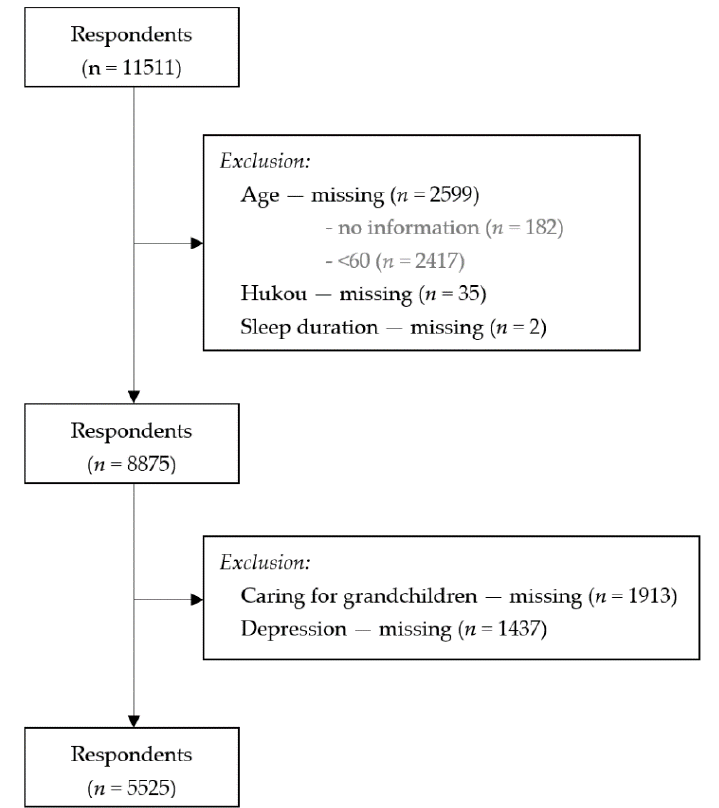
Figure 1. Flow diagram of samples, CHARLS (China Health and Retirement Longitudinal Study) 2018.